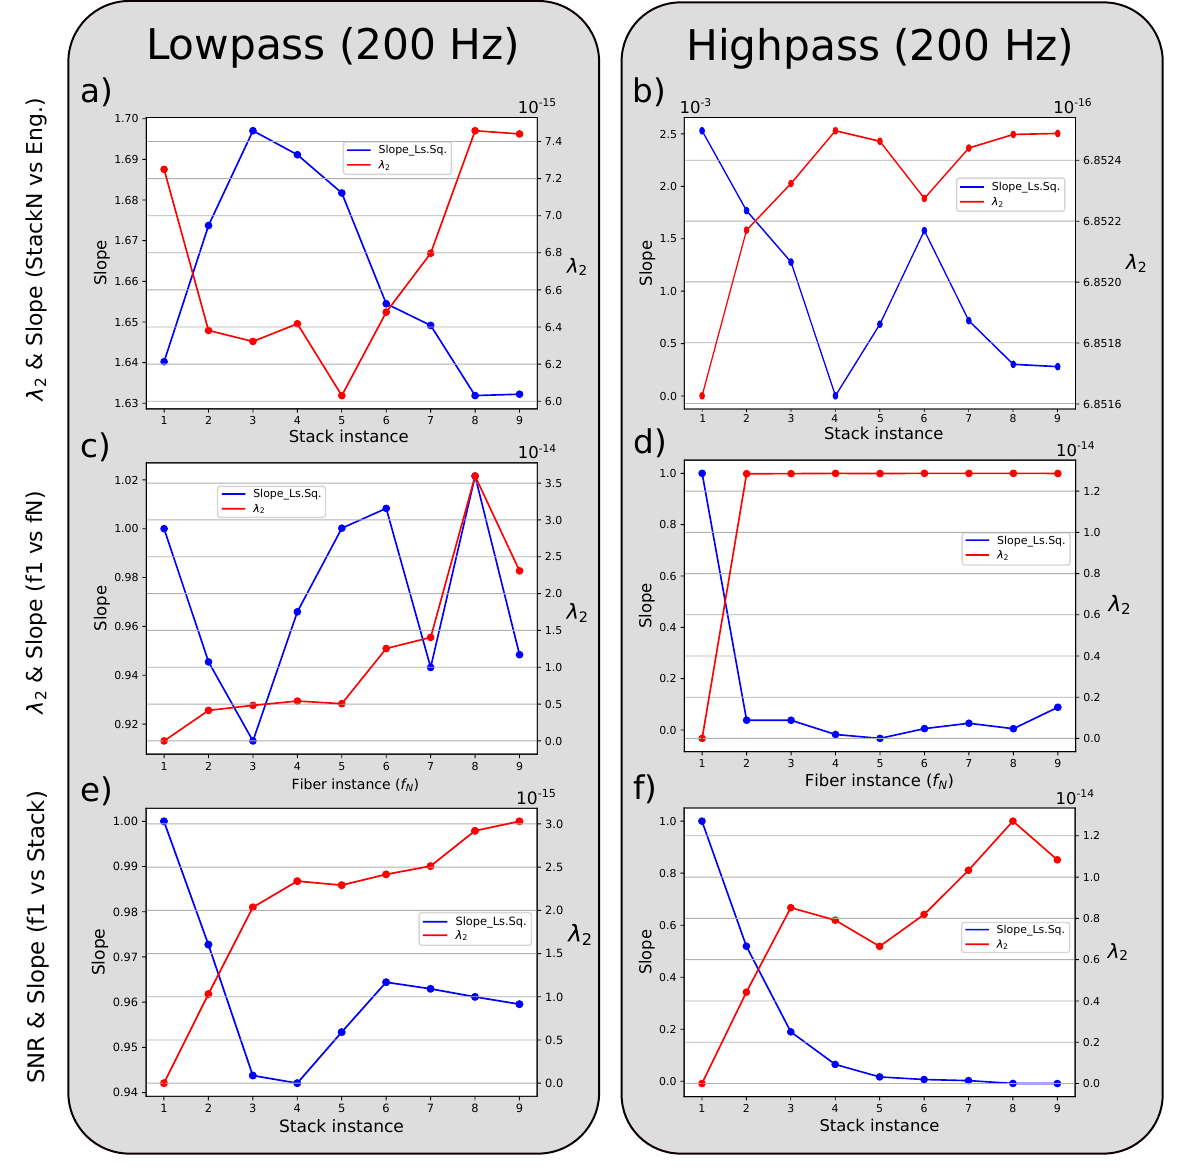
Figure 8. Calculated slope (blue curve) and λ 2 (red curve) from the PCA method for the tremor signal with an applied lowpass and highpass filters (200 Hz) at each of the following scenarios: standard stack instances vs. engineered fiber ( a , b ), standard fiber instance one vs. other standard instances ( c , d ), and standard fiber instance one vs. standard stack instances ( e , f ). Based on the results of Figure 8a, in Figure 9, we illustrate the comparison between fiber instance one DDSS data and the fifth stack instance of the standard fibers for the same tap test signal example as in Figure 4. The stacked DDSS data (b) show that random high and low strain values within the wavefield are removed when comparing against the first fiber instance (a) at the different interest areas of the DDSS data (green boxes 3, 4, and 5). Further, the stacked version smooths the data, and enables to observe an easy continuation of the wave phases (green boxes 1 and